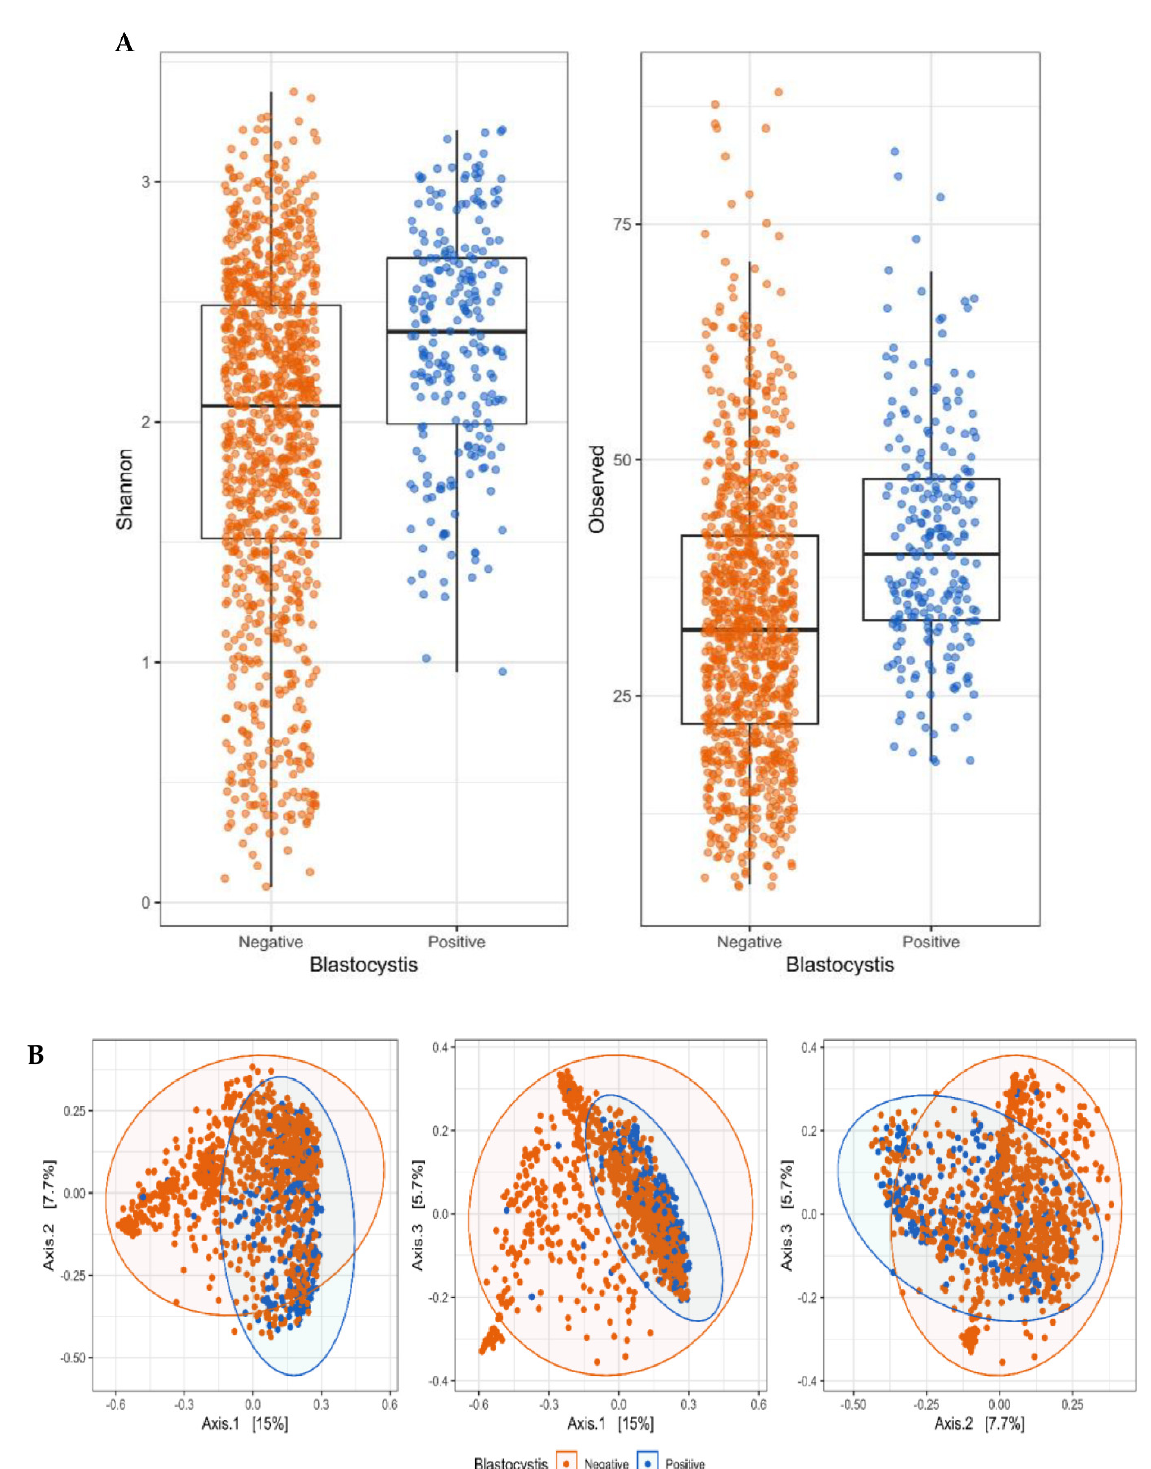
Figure 1. ( A ) Alpha diversity differences in Shannon’s diversity index ( left ) and observed richness ( right ) between Blastocystis -positive and Blastocystis -negative fecal DNA samples. Both measures differed significantly between the two types of samples ( p < 0.0001). ( B ) Beta diversity of Blastocystis - positive and Blastocystis -negative fecal samples visualized by PCoA plots of Bray–Curtis dissimilar- ities.